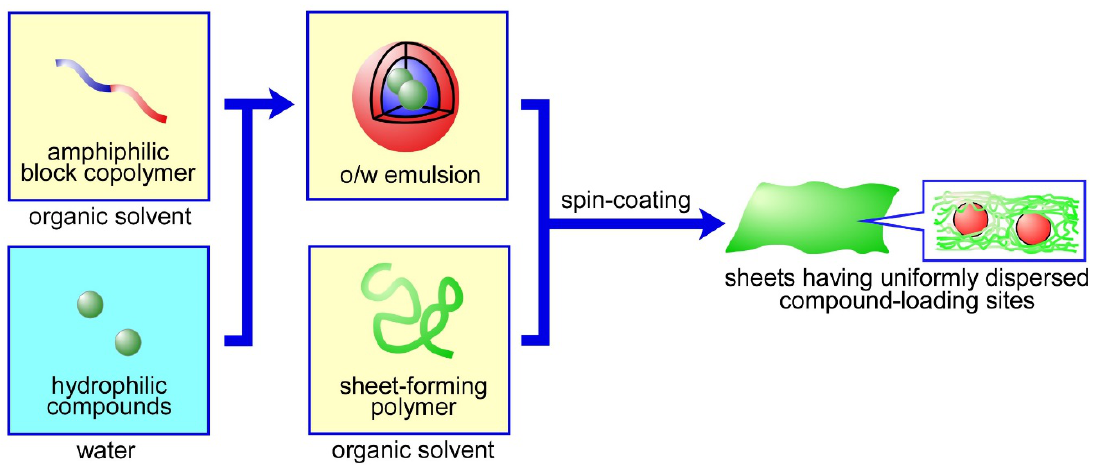
Figure 1. The preparation of sheets with uniformly dispersed compound-loading sites.